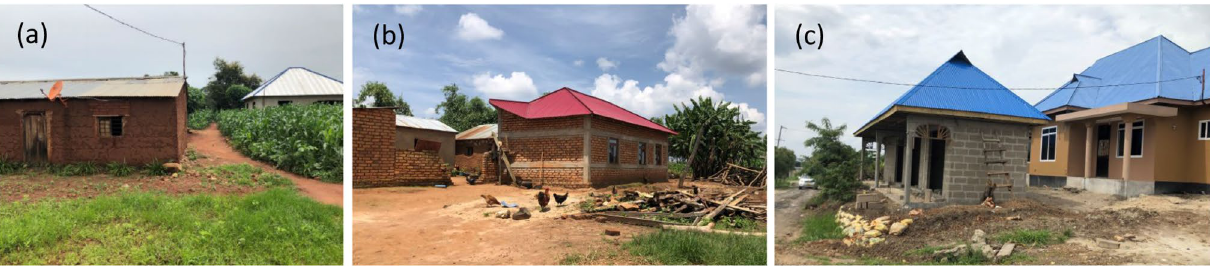
Fig. 1 Typical construction techniques in Tanzania. a Adobe dwelling; b rare burnt clay brick building with reinforced cement concrete (RCC) horizontal and vertical bands; c sand block building. Photograph by Giulia Jole Sechi, Iringa, Tanzania